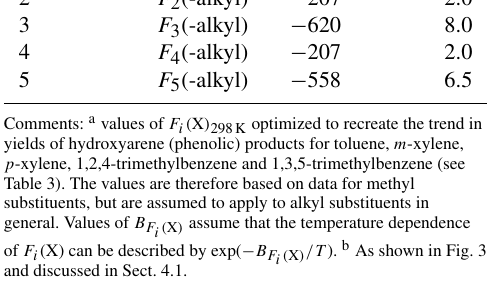
Table 7. Partial rate coefficients for the reactions of O 2 with OH-aromatic adducts, and their temperature dependences described by k = A exp ( − (E/R)/T ) . Parameters are shown for abstraction of hydrogen α to the -OH group ( k abs-O for β O 2 addition adjacent to the -OH substitution ( k ◦ add-O